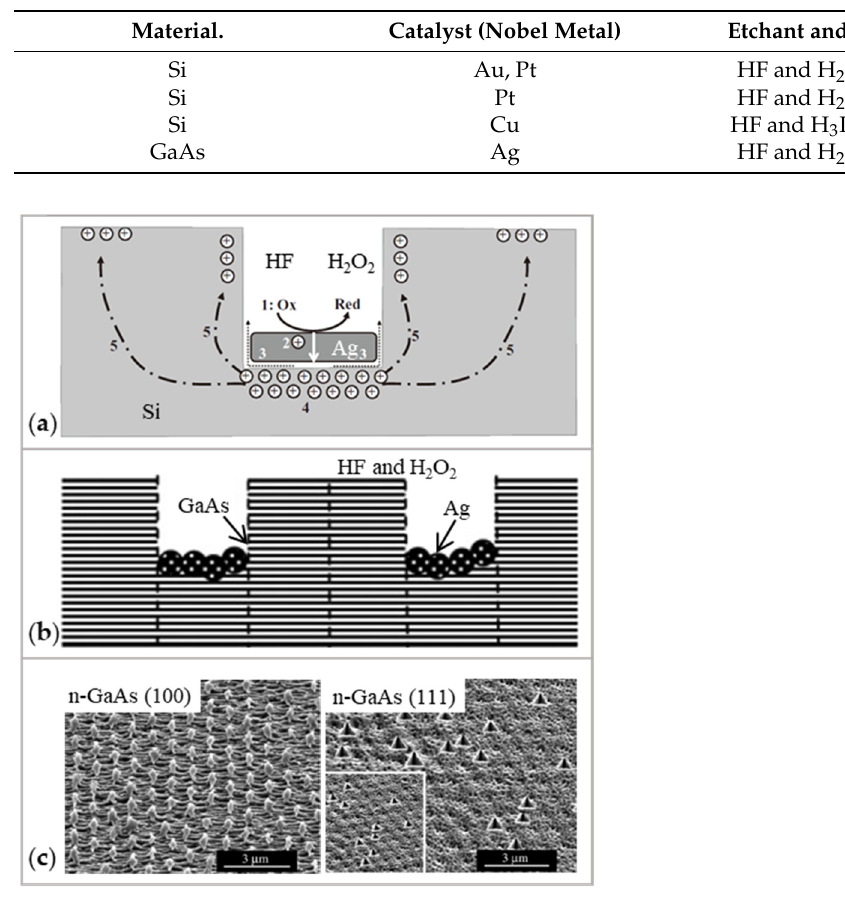
Figure 16. The MACE process: ( a ) The schematic diagram of processing Si [125]; ( b ) The schematic diagram of processing GaAs. Reproduced with permission from [129]; ( c ) The SEM micrographs of Ag-assisted etching for n-GaAs (100) and n-GaAs (111). Reproduced with permission from [129].